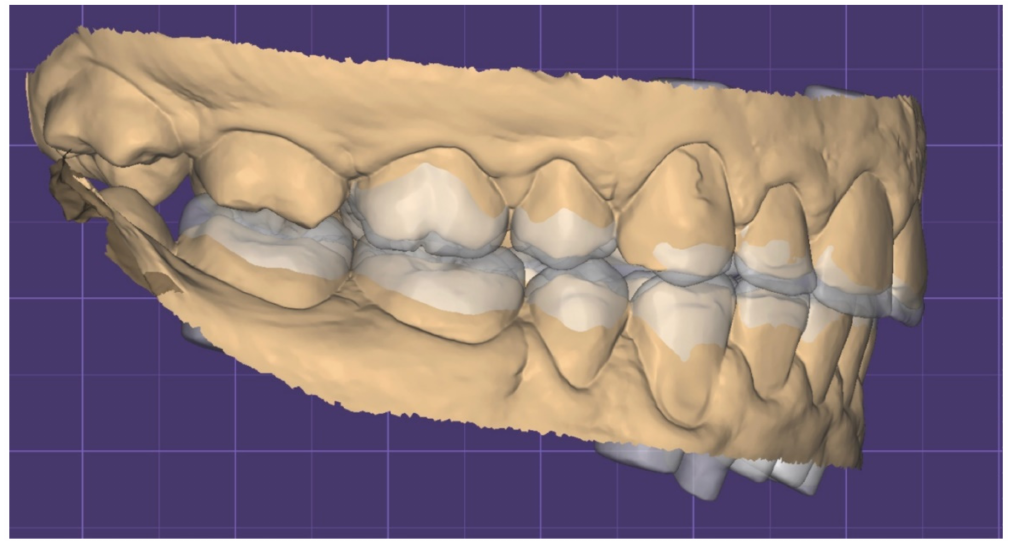
Figure 13. STL Digital wax up